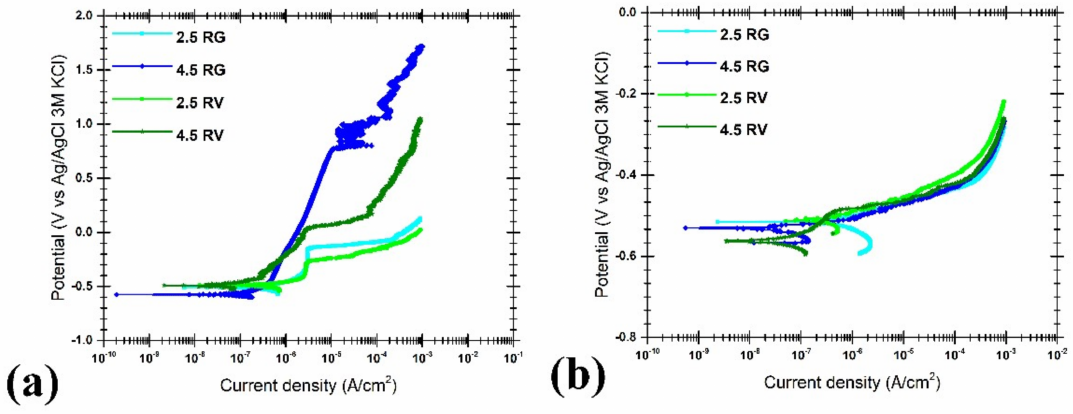
Figure 9. Potentiodynamic polarization curves in ( a ) the solution of 3.5 g/L (NH 4 ) 2 SO 4 and ( b ) the diluted Harrison